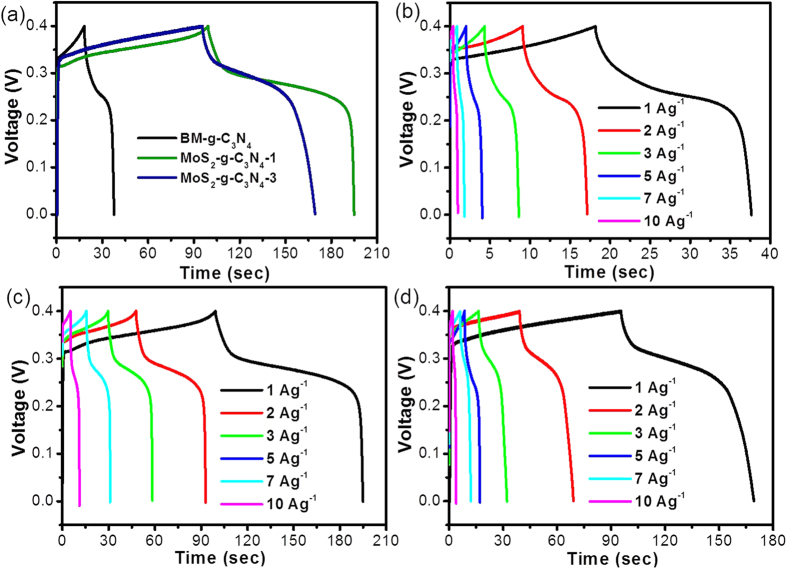
(a) Comparative galvanostatic CD profile of the BP-g-C3N4, MoS2-g-C3N4-1, and MoS2-g-C3N4-3 heterostructure electrode at a current load of 1 Ag−1, (b) Galvanostatic CD curves of BP-g-C3N4 at a current load of 1–10 Ag−1, (c) Galvanostatic CD curves of MoS2-g-C3N4-1 at a current load of 1–10 Ag−1, and (d) Galvanostatic CD curves of the MoS2-g-C3N4-3 heterostructure at a current load of 1–10 Ag−1.